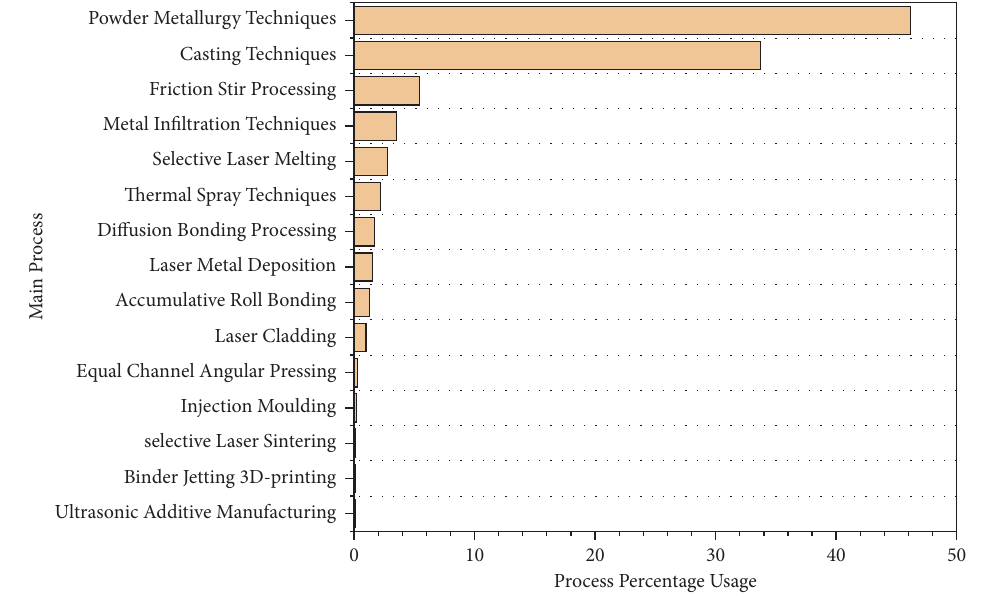
Figure 20: Comparison of MMCs Processing techniques [15]. Table 7: Comparison of MMC liquid state manufacturing methods [120].